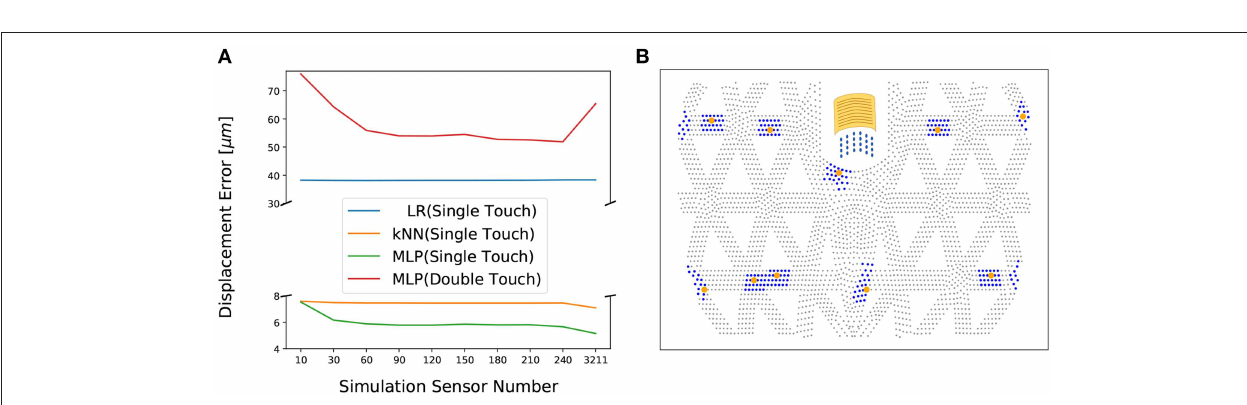
Frontiers in Neurorobotics |